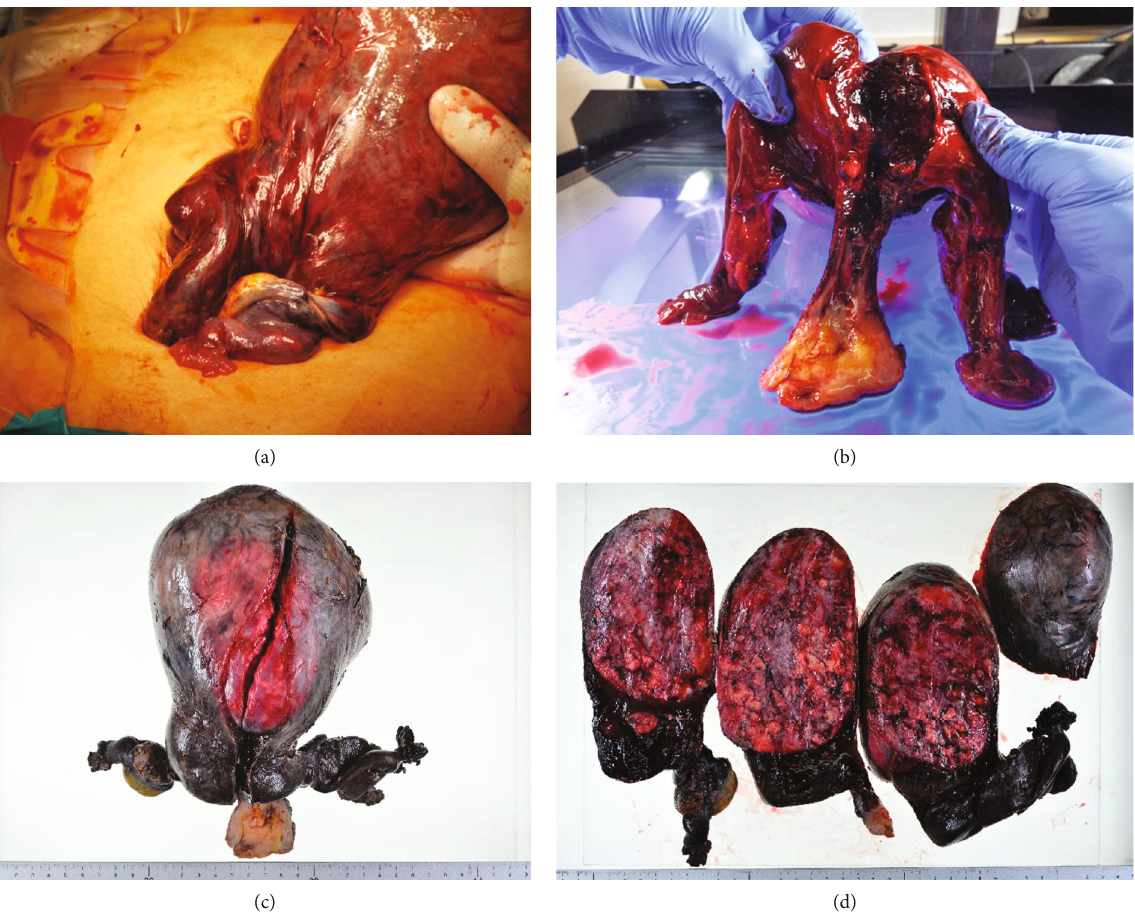
Figure 2: Operative fi ndings and gross section of the uterus. The gross material revealed that the uterus was rotated 540 degrees counterclockwise at the level of the junction between the cervix and the uterine body. Both fallopian tubes and uterine body were discolored and necrotic. The cervix was atrophic and unusually elongated (a, b). Pathologic fi ndings were uterine interstitial leiomyoma with di ff use calci fi cation and hemorrhagic necrosis, weighing 1360g in total (c, d). Both ovaries, fallopian tubes, and uterine body were necrotic, suggesting total tissue infarction due to the axial rotation of the